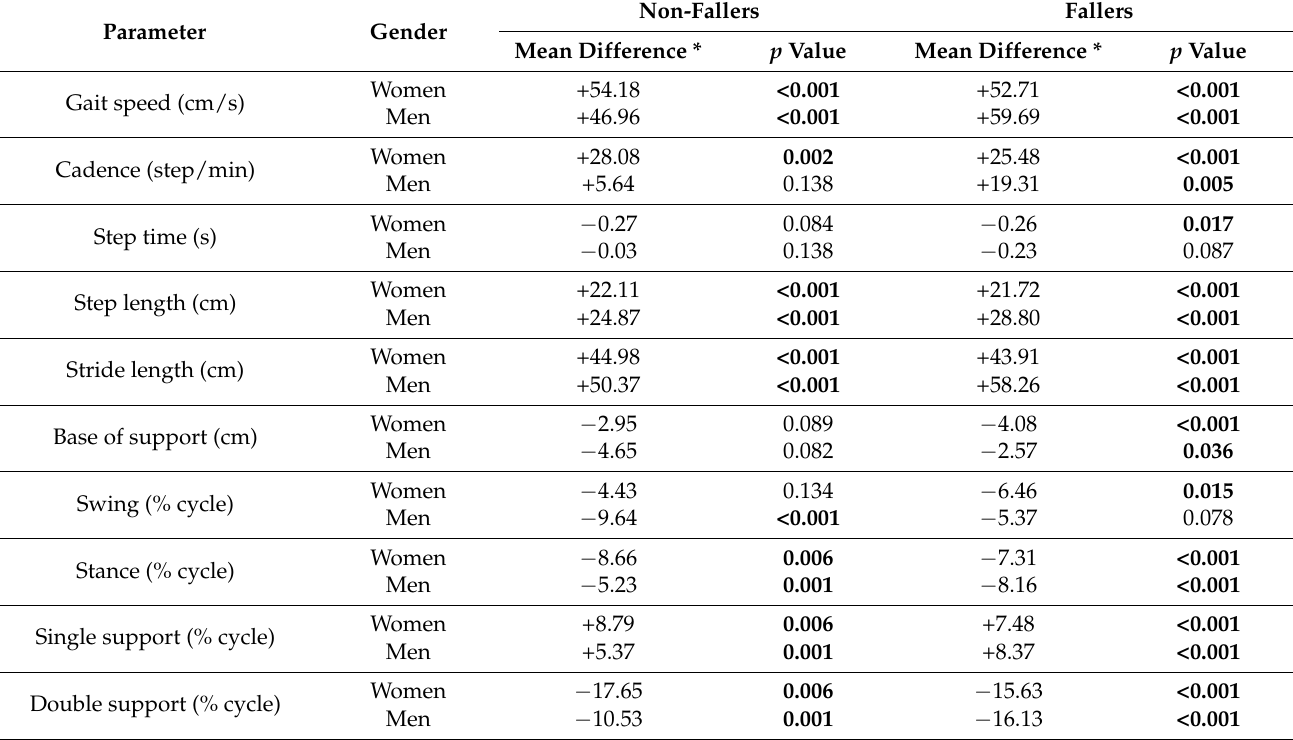
Table 2. Table 2. Gait parameters and comparison with reference